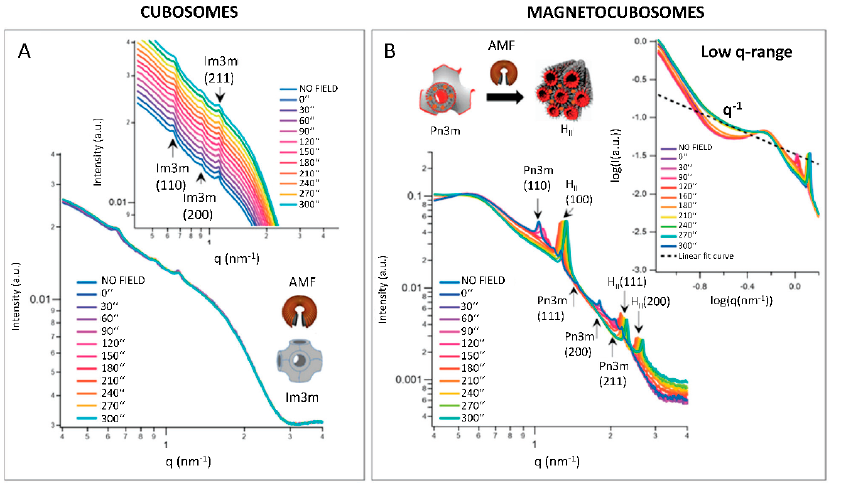
Figure 4. Response of ( A ) GMO cubosomes and ( B ) superparamagnetic cubosomes (showing a phase transition from Pn3m (cubic) to HII (hexagonal) crystalline phase) exposed to an alternated magnetic field. The Miller Indexes for the respective crystalline phases are indicated. Each SAXS profile corresponds to a different application time of the magnetic field. Inset in ( A ) highlights the scattering peaks of cubosomes. Inset in ( B ) represents a magnification of the low-q region of the scattering profile. The pearl-necklace-like arrangement of magnetocubosomes after 210 s of exposure to the magnetic field is evidenced by the appearance of a q − 1 scalar law. (Reproduced with permission from [42]).